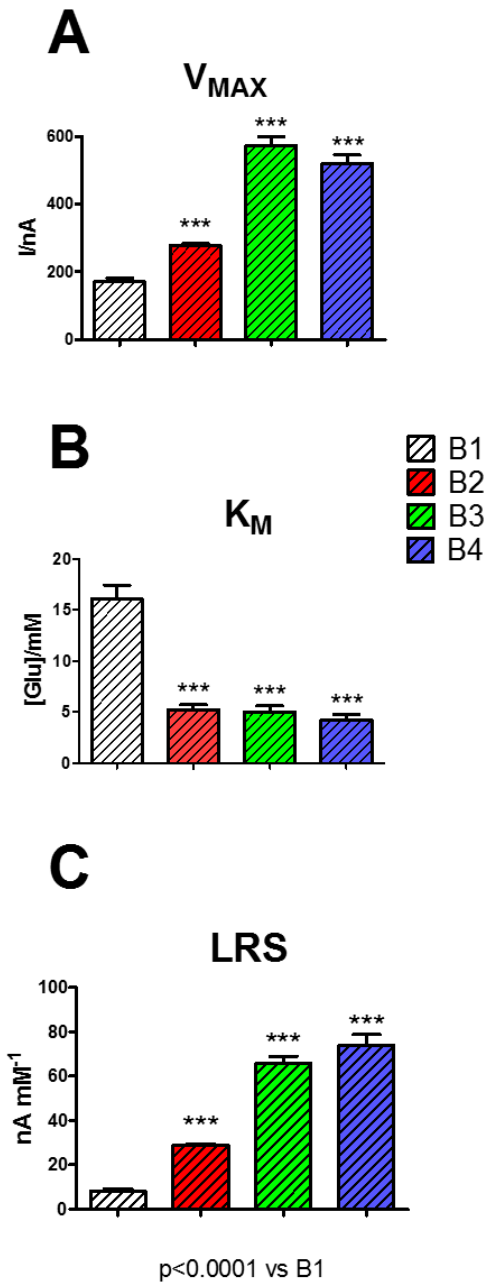
Figure 5. Bar chart displaying the changes of V MAX (Panel A ), K M (Panel B ), and LRS (Panel C ) on different biosensor designs loading five layers of the mixture at different compositions. White bar: B1 [GEL (5%) + GOx]; red bar: B2 [GEL (5%) + PEI (1%) + GOx]; green bar: B3 [GEL (5%) + GLY (1%) + GOx]; blue bar: B4 [GEL (5%) + PEI (1%) + GLY (1%) + GOx]. Values are expressed as mean ± SEM. * p < 0.0001 vs. B1.